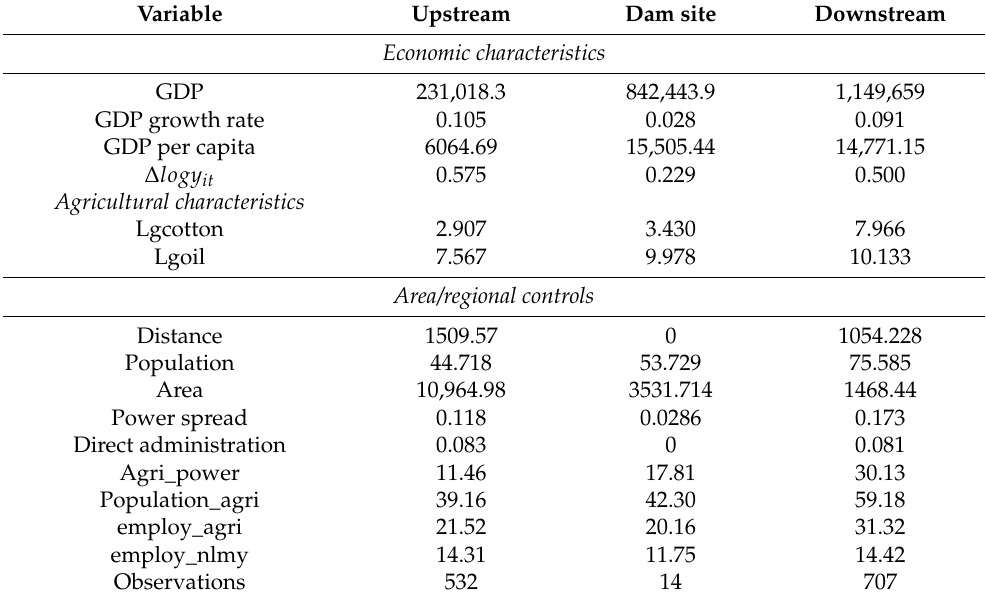
Table 4. More details of the treatment group (Average data values of the upstream, dam site and downstream).